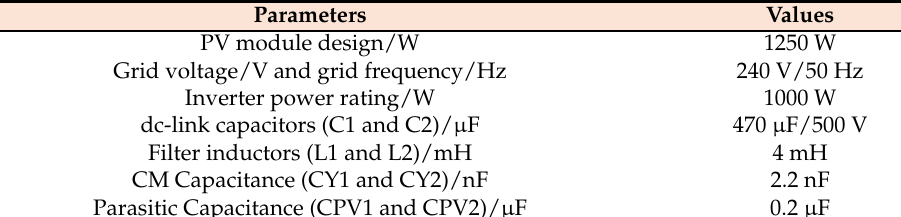
Table 3. Simulation parameter of PV and grid-connected TL-TNP-MLI.